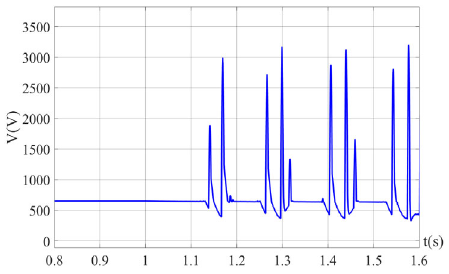
Figure 13. The DC bus side voltage (Group B).